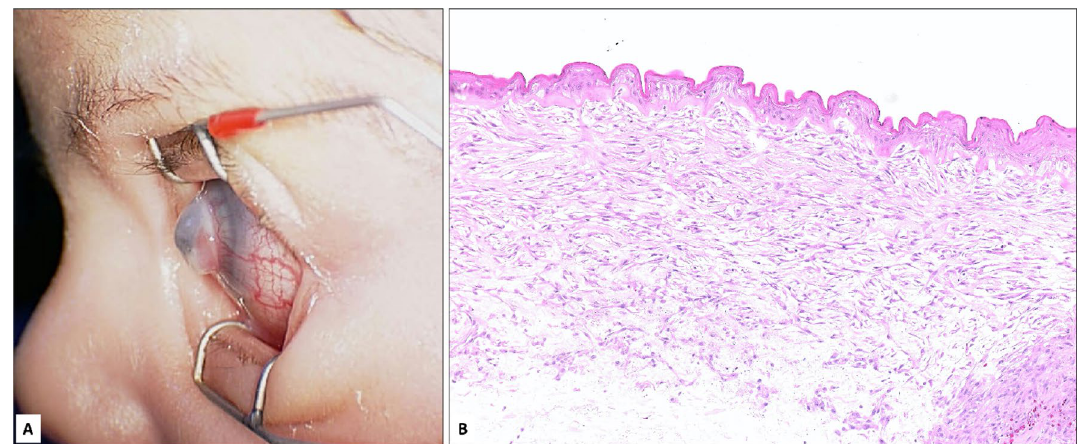
Figure 4. ( A ) Another case of Peter’s anomaly with an impressive looking myxoma clinically in case 8. ( B ) The histopathological appearance of the corneal subepithelial myxoma shows absent Bowman’s layer and the typical hypercellular spindle-shaped cells similar to the previous case in Fig. 3 (× 200 magnification, Hematoxylin and